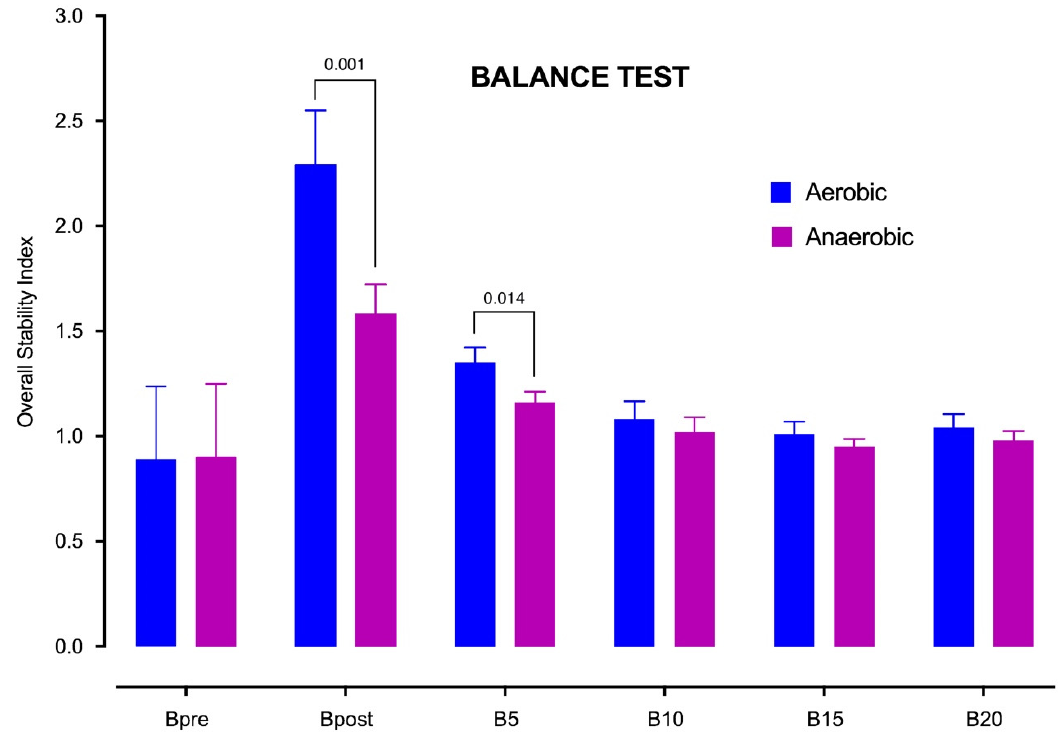
Figure 2. Overall stability index across the experimentation. Aerobic condition vs. anaerobic condition.